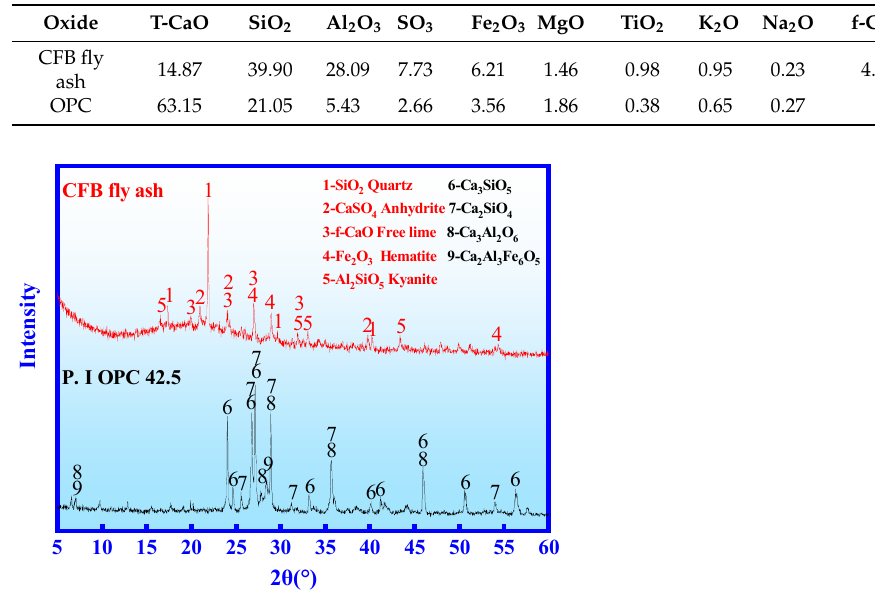
Figure 1. Mineral compositions of CFB fly ash and OPC. The particle size distribution is an important parameter of raw material. Figure 2 shows the particle size distributions of CFB fly ash and OPC. The particle size range of CFB fly ash is broad, mainly around 5.02 and 25.18 μ m, whereas the particle size of OPC is focused on 39.91 μ m. The D 50 and D 90 of CFB fly ash are 7.88 and 41.31 μ m, which are lower than the those of OPC (24.81 and 62.59 μ m. The densities of CFB fly ash and OPC are 2375.44 kg/m 3 and 3062.51 kg/m 3 , respectively. According to GB/T 8074–2008 [26], the specific surface area of CFB fly ash and OPC is 520 m2/kg and 350 m2/kg, respectively. In additional, the specific surface area of CFB fly ash in this work is higher than that of Zhang (270 m 2 /kg) [1] and Zhou (121 m 2 /kg) [20]. The particle morphology and pore structure of the CFB fly ash are optimized. Therefore, this CFB fly ash could provide better pozzolanic activity and strength for CMM [21].